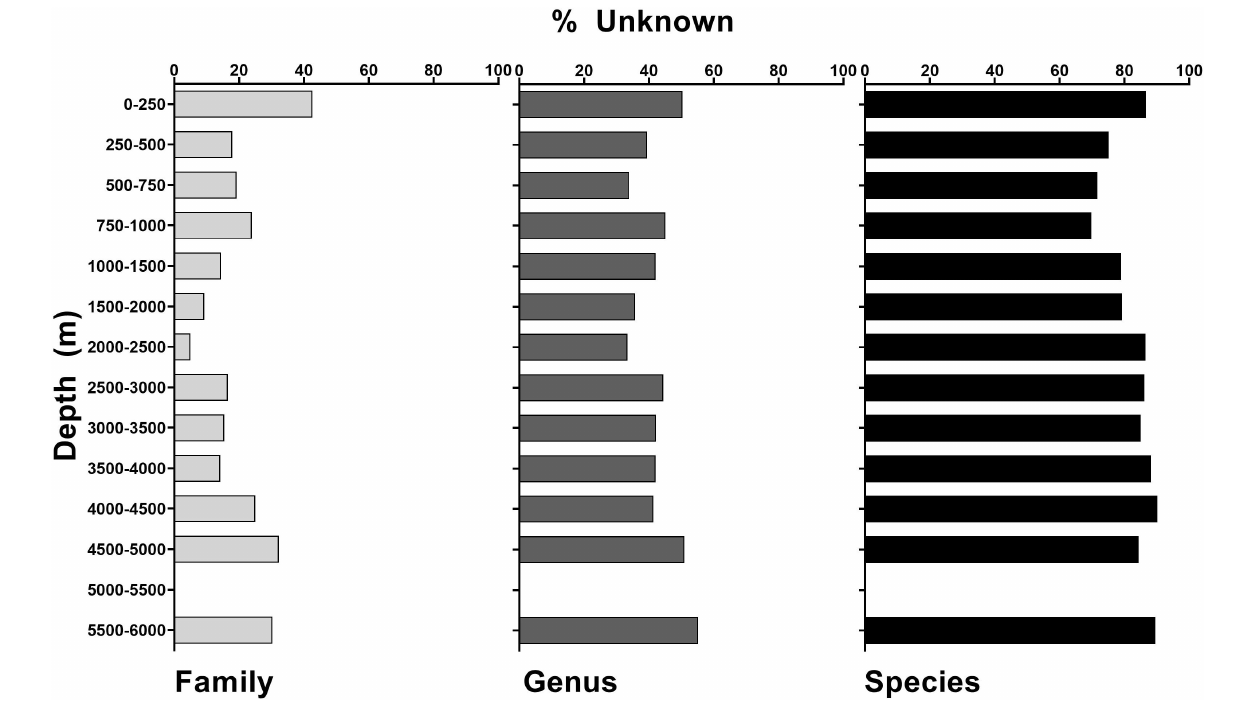
FIGURE 3 | Unidentified annotations (%) across all taxa at the family, genus, and species levels for all of CAPSTONE, demarcated by depth ranges.